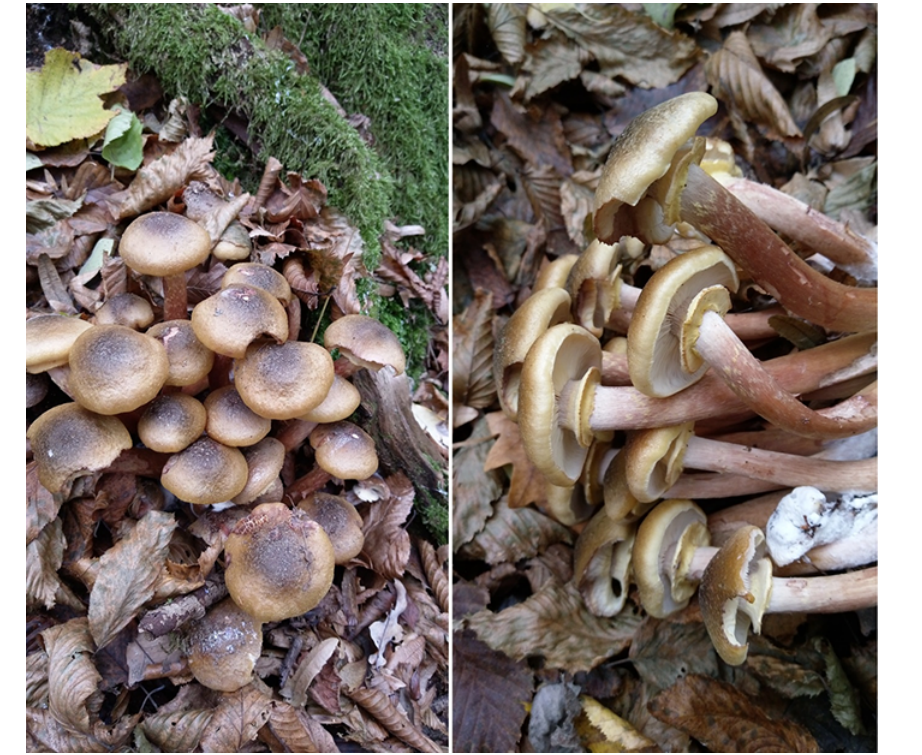
Figure 5 Basidiomata of Armillaria mellea (Vahl) P. Kumm. s. str. Photography by Anna